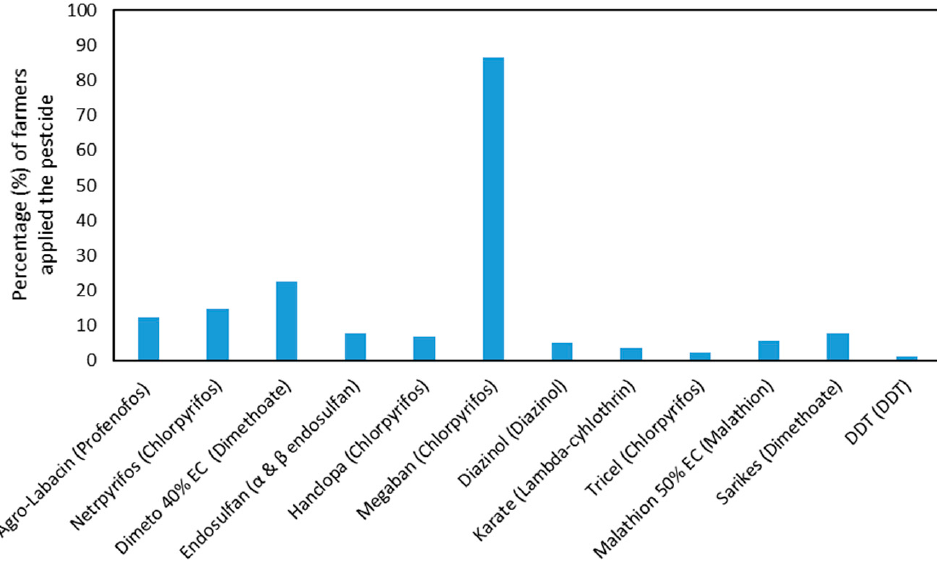
Figure 3. Pesticide applied by small farm holder farmers and percentage of farmers used the pesticide to one of the crops either in irrigation or rainfed agriculture.